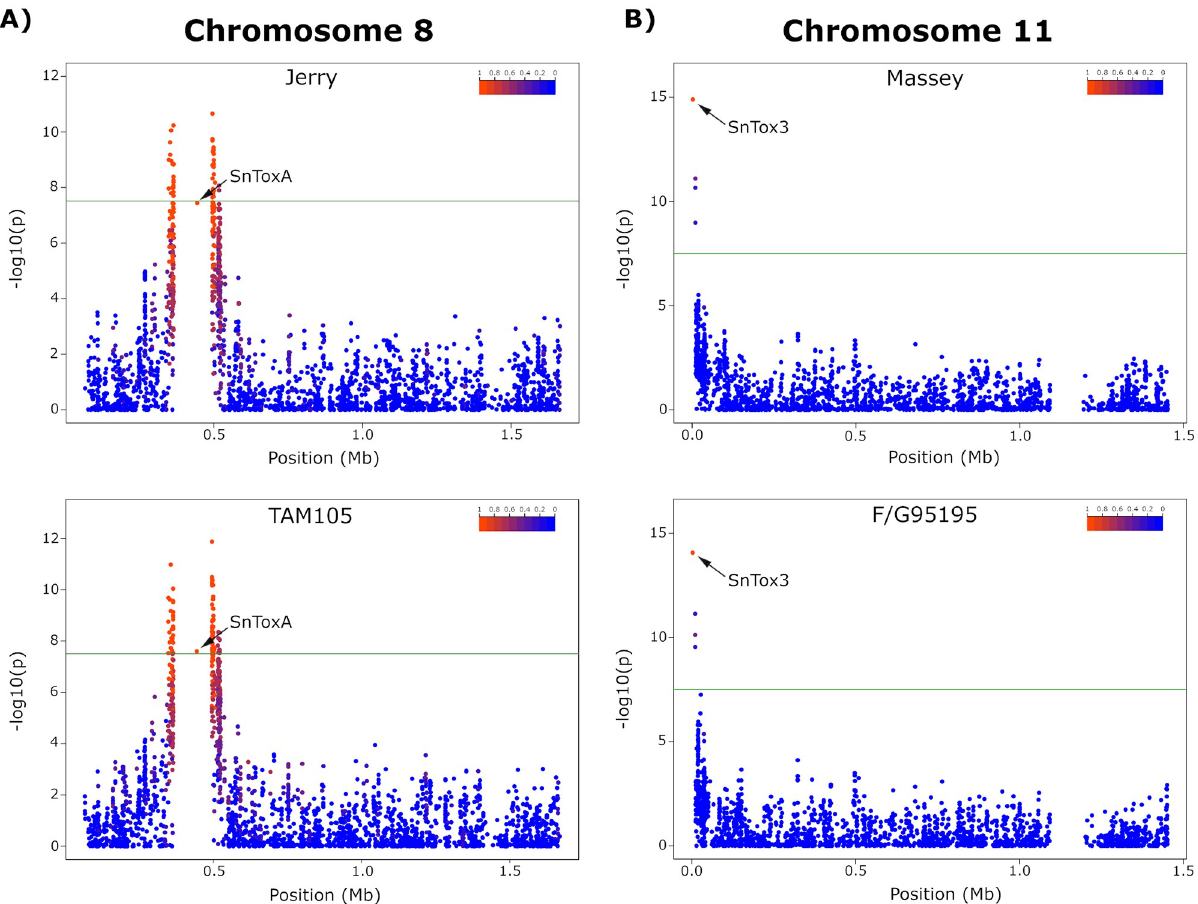
Fig 4. Genome-wide association study (GWAS) detecting significant associations with virulence on wheat lines Jerry, TAM105, Massey, and F/ G95195. (A) Manhattan plot of P . nodorum chromosome 8 illustrating a highly significant association with the SnToxA locus for isolates inoculated onto hard red winter wheat lines Jerry and TAM105. Markers are represented by dots which are colored corresponding to the level of linkage disequilibrium (R 2 ) with the most significant marker and are order by position on the x-axis. The significance of each marker expressed as–log10(p) is displayed on the y-axis. (B) Manhattan plot of P . nodorum chromosome 11 illustrating a highly significant association with the SnTox3 locus for isolates inoculated onto soft red winter wheat lines Jerry and TAM105. Markers are represented by dots which are colored corresponding to the level of linkage disequilibrium (R 2 ) with the most significant marker and are ordered by position on the x-axis. The significance of each marker expressed as–log10(p) is displayed on the y-axis.